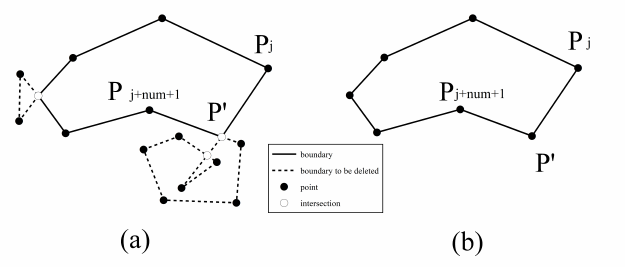
Figure 6. ( a ) Schematic diagram of recognition and ( b ) processing of bottom